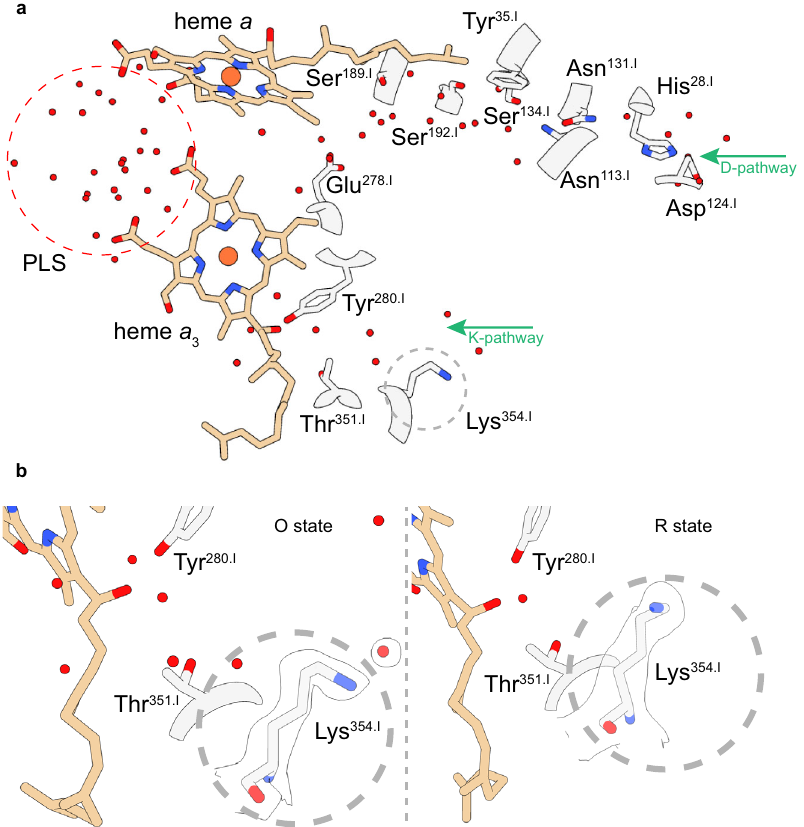
Fig. 6 Proton transfer pathways in C c O. a A structural overview of the two proton transfer pathways. The K and D-pathway are de fi ned by their respective amino acids. Several water molecules could be assigned in each pathway and an accumulated water cluster could be seen near the A-ring propionate of heme a 3 , presumably the proton-loading site (PLS). b A redox-dependent positional change of the side chain of the key residue Lys 354.I , located in the K- pathway, was observed. It looks as the reduction of the BNC leads to an electrostatic attraction of the potentially positively charged side chain of Lys 354.I . The corresponding density map is illustrated as a white surface. Illustrated map densities are fi ltered to equal contour levels of